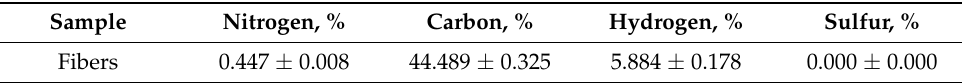
Table 3. Elemental analysis of cellulose fibers discarded by the Papermaking Industry. Sample